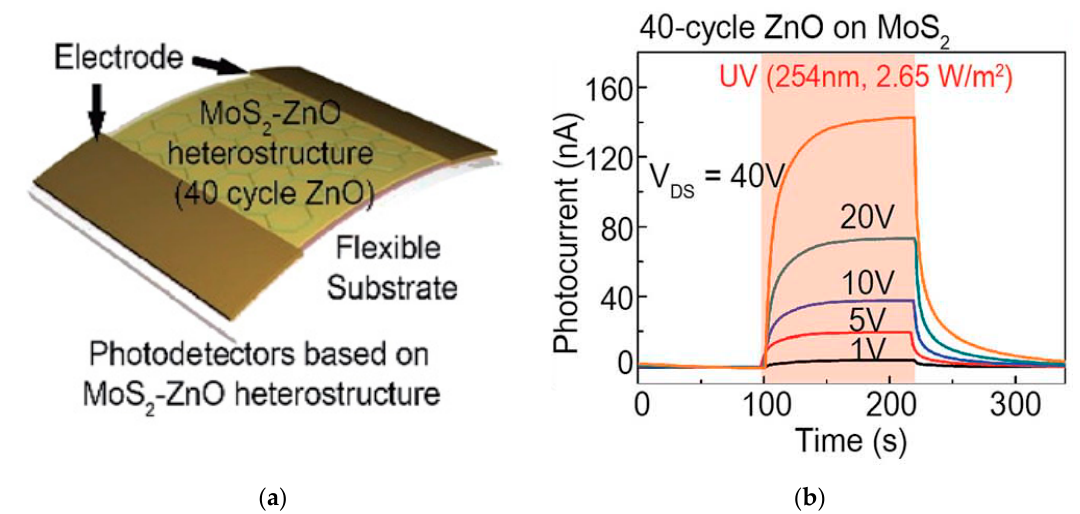
Figure 15. ( a ) Scheme of a phototransistor based on a MoS 2 -ZnO structure and developed on a flexible PET substrate; ( b ) response of the phototransistor to an incident UV (254 nm) light over time. Reprinted with permission from ref. [54]. Copyright 2019, Creative Commons Attribution 3.0 Unported Licence.